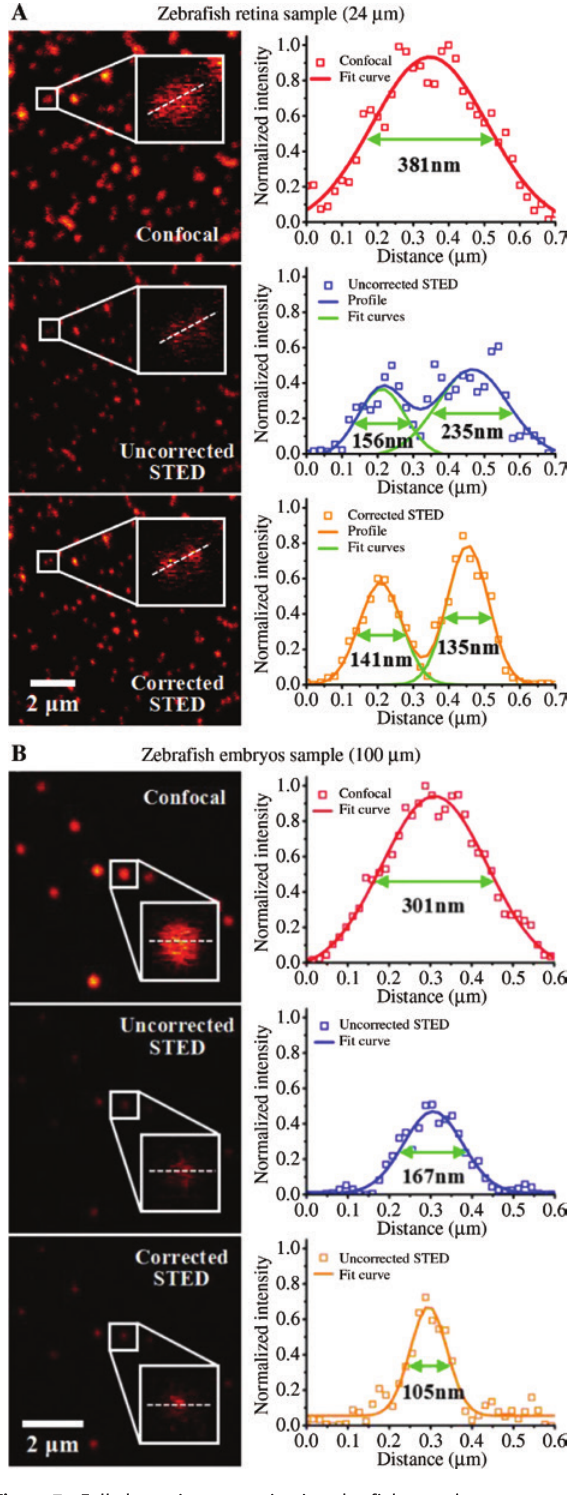
Figure 7: Full aberration correction in zebrafish samples. (A) Images of 100 nm fluorescent microspheres through zebrafish retina with the thickness of 24 μ m, and the normalized intensity profiles along white dotted lines. (B) Images of 100 nm fluorescent microspheres though zebrafish embryos section with the thickness of 100 μ m, and the normalized intensity profiles along white dotted